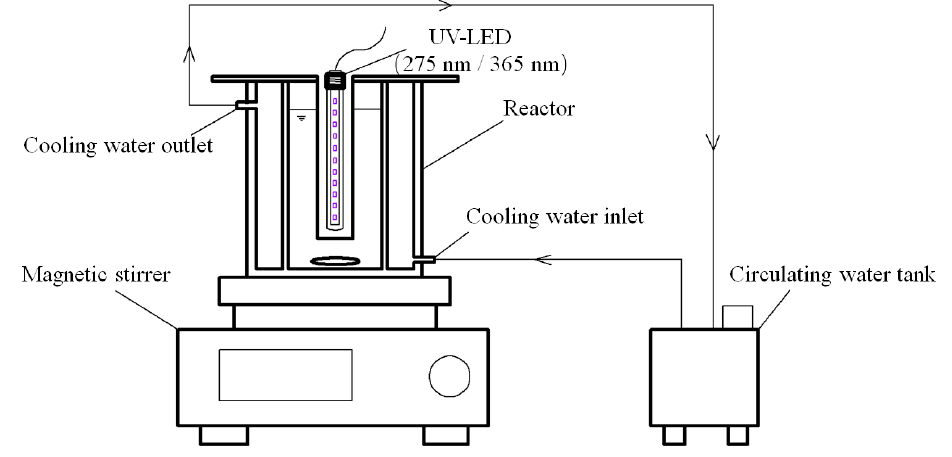
Figure 12. The diagrammatic representation of UV-LED/TiO 2 photocatalytic device.